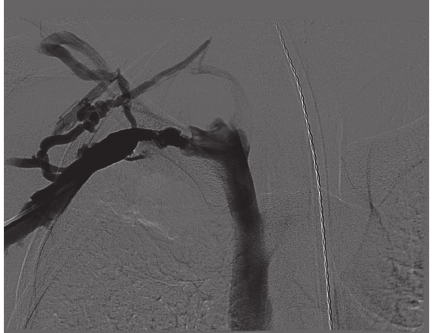
Figure 3: Preoperative angiogram of the right upper extremity revealing attenuation of contrast flow at the level of the subclavian vein secondary to thrombosis.